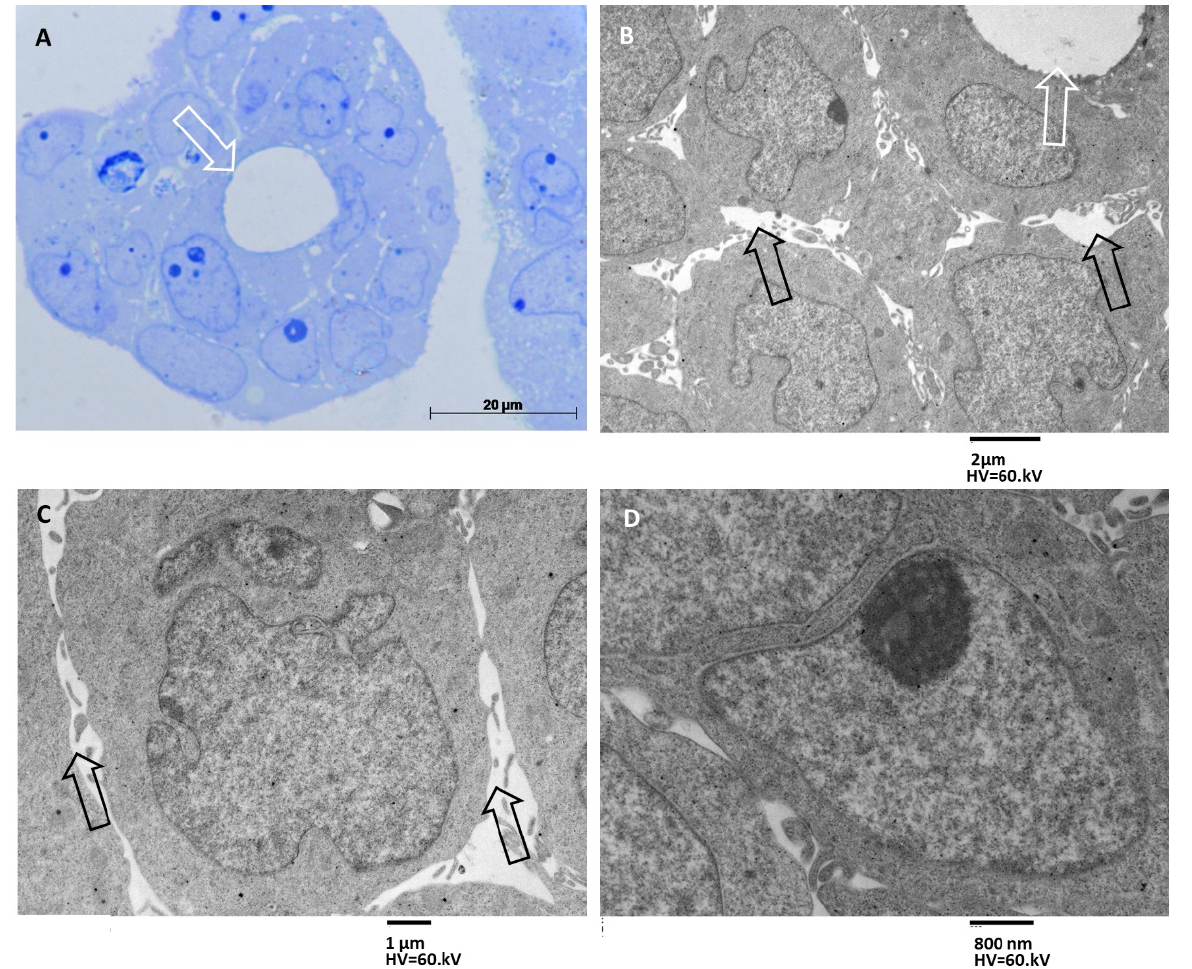
Figure 2. MTSs of Group A. ( A ) Light microscopy image of a bi-layered spheroid containing a pseudocyst-like structure. Magnification 400 × , bar 20 µ m. ( B ) TEM image. Cells lining the lumen (white arrow) of the pseudocyst are tightly adherent to each other, and no exosome secretion in the lumen of the pseudocyst was visible. Magnification 1250 × , bar 2 µ m. ( C ) TEM image. Cells in the outermost layers appear loosely adherent to each other and separated by large intercellular spaces (black arrows) in which cells’ membrane finger-like extroversions extend. Magnification 1600 × , bar 1 µ m. ( D ) Finger-like membrane extroversions were sometimes short and, at other times, were longer and convoluted, intertwining with those of adjacent cells. No exosome secretion in the intercellular spaces was visible. Magnification 1800 × , bar 800 nm.